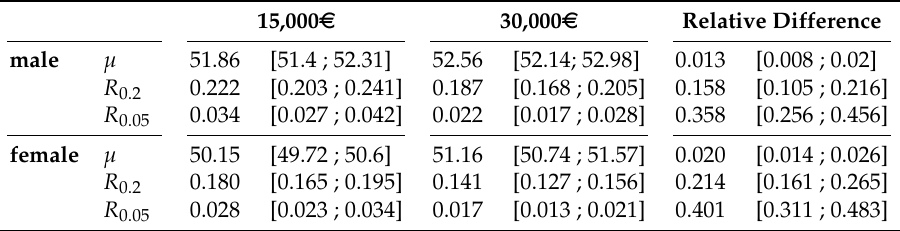
Table 2. Expectation and risk measures for average Joe and Jane at income levels of 15,000 e and 30,000 e